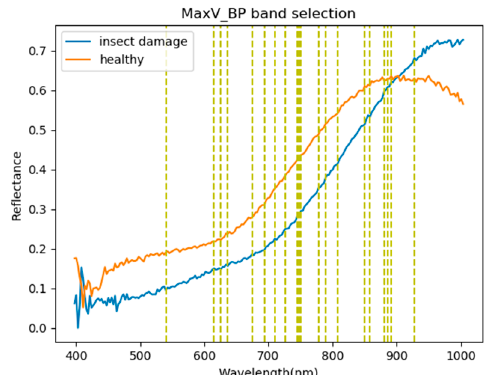
Figure 12. Visualization of the MaxV_BP band selection results. The first five bands are 858, 927, 850, 674, and 891 nm.